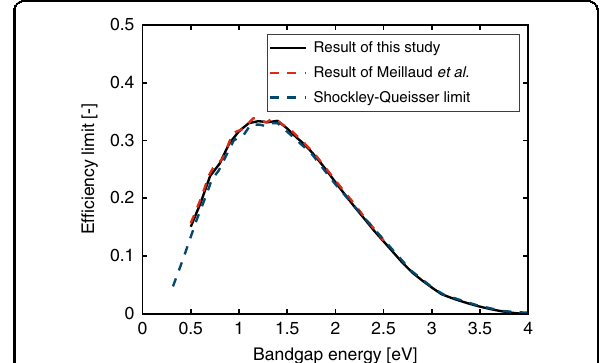
Fig. 13 Electrical ef fi ciency limits of single-junction solar cells under the AM1.5 standard predicted by this study, validated against the results from Meillaud et al. 33 , and Shockley and Queisser 11,48